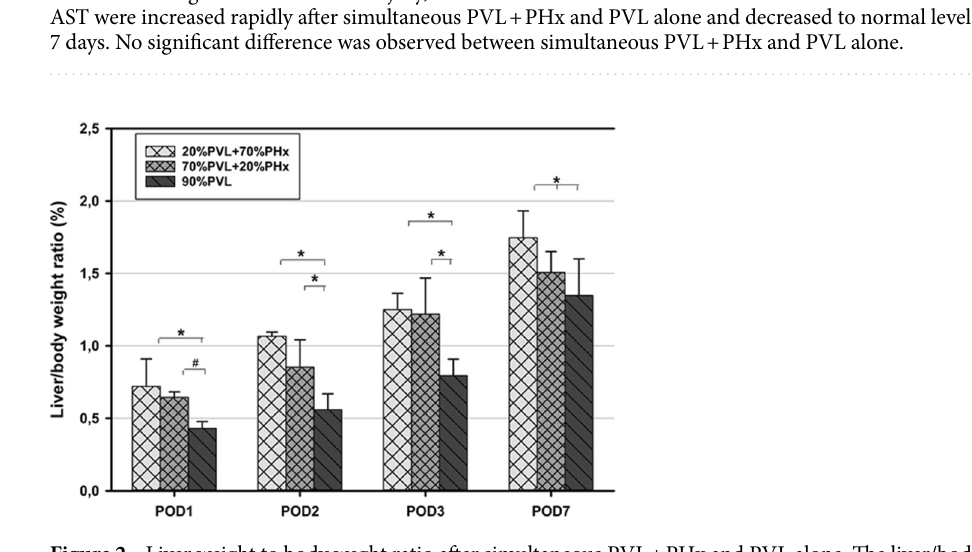
Figure 2. Liver weight to body weght ratio after simultaneous PVL + PHx and PVL alone. The liver/body weight ratio increased steadily after operation. The ratio was significantly higher after additional PHx compared with PVL alone (* p value < 0.05, # p value <